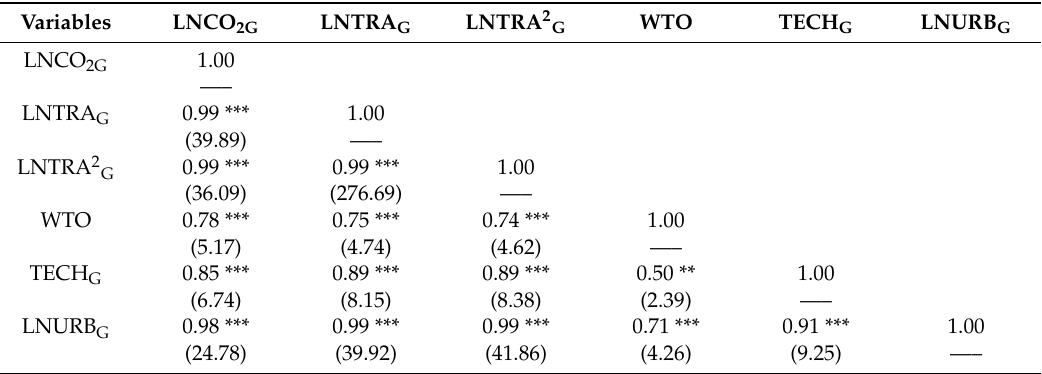
Table 5. Correlation analysis results for